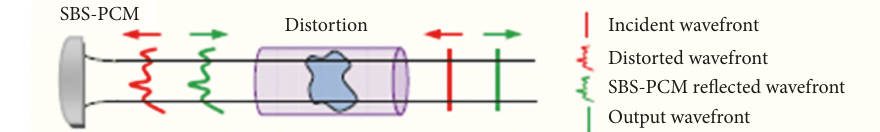
Figure 3: Distortion compensation with a SBS-phase-conjugate mirror [adapted from [5]].